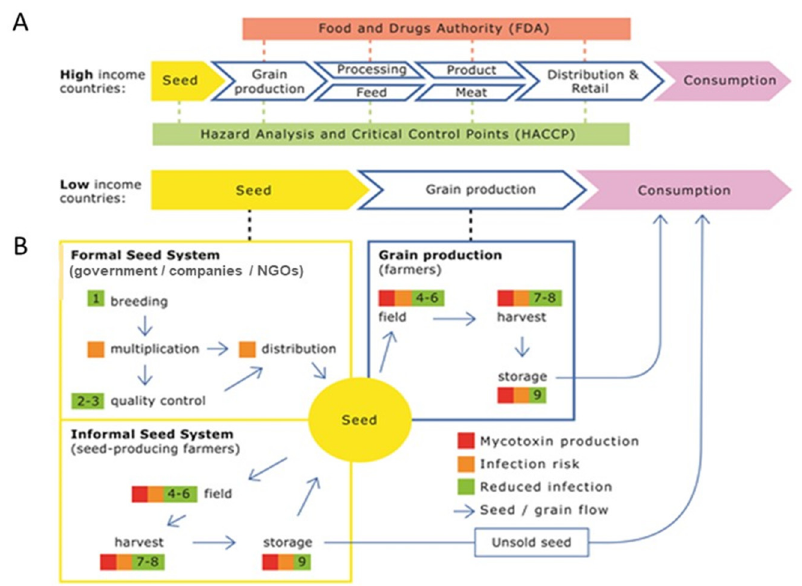
Figure 1. ( A ) Maize value chains in high- and low-income countries. Regulation by, e.g., the FDA and certifications such as HACCP avoid mycotoxin contamination in maize in high-income countries. Low-income countries lack sufficient regulations or implementation systems to avoid mycotoxin contamination in maize. A relatively large share of the maize production is consumed without industrial processing, resulting in a shorter value chain compared with the chains in high-income countries. ( B ) An idealized picture of the effects of formal and informal seed systems on mycotoxigenic fungal infection, mycotoxin production, and control methods in low-income countries. The formal seed system consists of government bodies, NGOs, and private companies involved in breeding, seed multiplication, external quality control, and dissemination of seed, while the informal seed system only consists of seed-producing farmers. In the formal seed system, contamination should not occur as seed health is maximized and seed treatment is standard practice to avoid survival of any possible pathogen, including mycotoxigenic fungi. Our case study (see text) demonstrates that a suboptimally functioning formal seed system may also result in seed stocks with some contamination. Arrows show flows of maize seed or grain. Control methods to avoid or reduce mycotoxigenic fungal infection include breeding insect- and mycotoxigenic fungi-resistant varieties (1), seed health testing (2), seed treatment with fungicides or biological control agents (3), atoxigenic strains (4), agrochemical application (5), biological control (6), avoiding seed damage (7), fast drying to <14% moisture (8), and clean and dry storage (9). An important question remains whether mycotoxin-producing fungi are ubiquitous in soils where maize is grown.